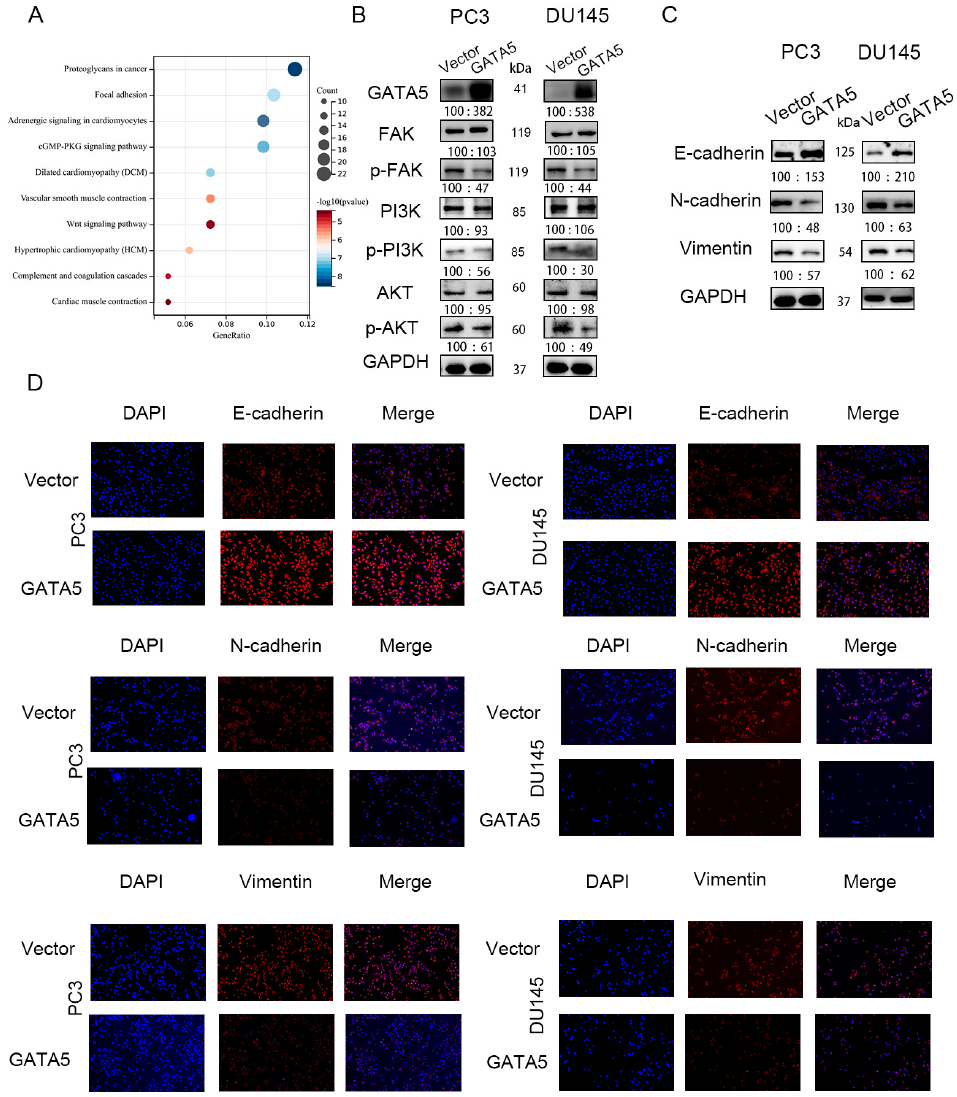
Figure 4. GATA5 mediates EMT via the FAK/PI3K/AKT pathway. ( A ) The result of enrichment of the KEGG pathway demonstrated that GATA5 was involved in PCa progression through the FAK/PI3K/AKT pathway. ( B ) The p-FAK expression and the downstream signaling pathway pro- teins, p-PI3K and p-AKT, were assessed by Western blotting analysis. ( C ) Overexpression of GATA5 inhibited the process of EMT, which was verified by the Western blotting. ( D ) Immunofluorescence verified the Western blotting results.